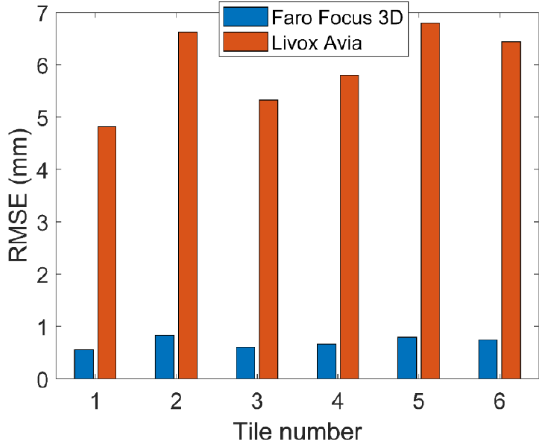
Figure 5. Benchmarking of the LiDAR systems’ standard deviation. RMSE indicates the root mean square error of the point cloud fitting to a plane using least squares fitting.